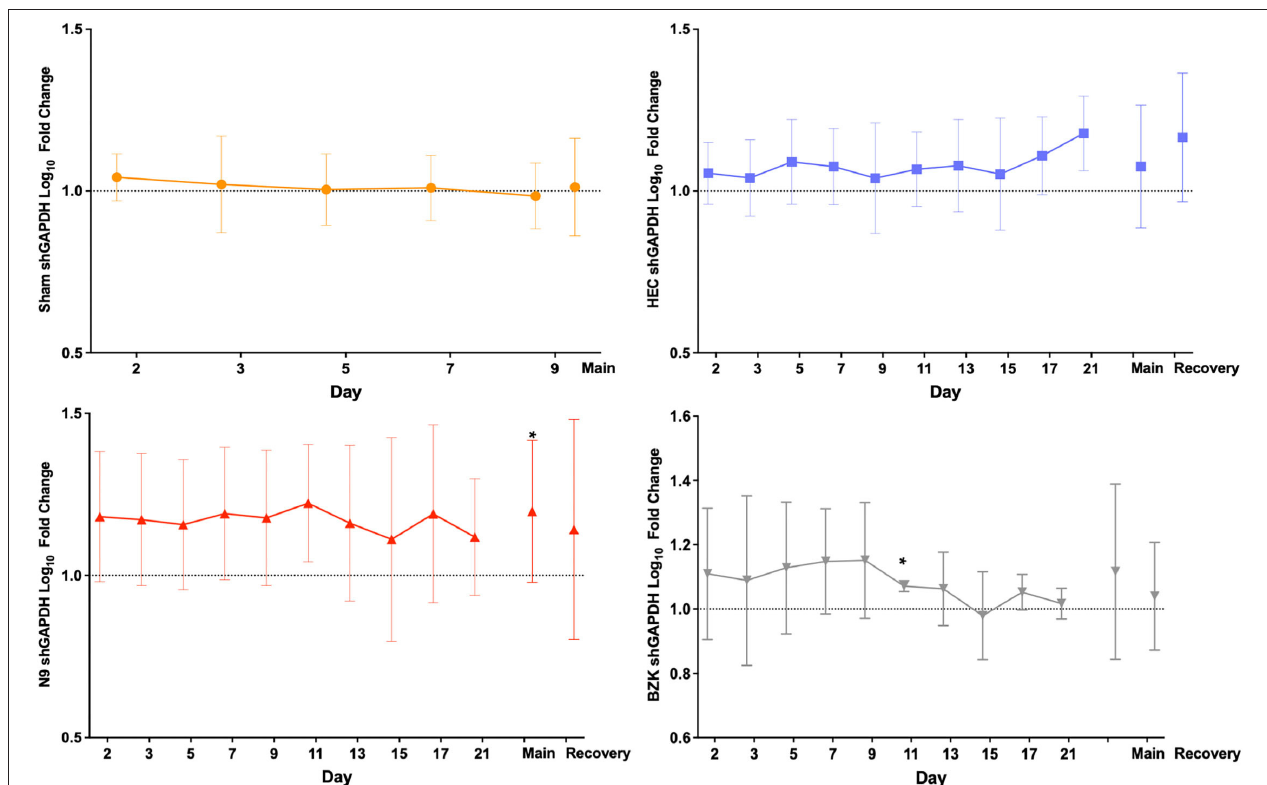
FIGURE 2 | Average log 10 fold change from baseline levels of sheep vaginal cell counts (shGAPDH). The impact of Sham (top left), hydroxyethylcellulose (HEC) placebo gel (top right), nonoxynol-9 (N9) gel (lower left), or benzalkonium chloride (BZK) solution (lower right) applied daily for 10 days to the sheep vaginal cavity was assessed by collection of vaginal swabs during phase 3 of the study. Each swab was processed for shGAPDH loads by quantitative polymerase chain reaction (qPCR) that were log 10 transformed and compared to the individual day 1 (D1) pre-dose baseline for each animal. The fold change was then averaged by the group for all study days in both the treatment (main, D1–D10) and recovery (D11–D21) periods of the study, and plotted with standard deviations. The maximal difference from baseline for the main and recovery periods are shown as individual values on the right side of each graph for the three treatment groups where recovery period samples were collected. Daily and maximum (main and recovery periods) log 10 fold change in shGAPDH levels were tested for normality (e.g., Shapiro–Wilk test). Daily and maximum (main and recovery periods) log 10 fold change in shGAPDH levels were compared for treatment effects by either parametric (e.g., ANOVA) or non-parametric (e.g., Wilcoxon) methods. Pairwise comparisons between groups were adjusted (Tukey or Dunnett) for multiple comparisons. * = p < 0.05. Non-transformed average daily values are presented in Supplementary Figure 1